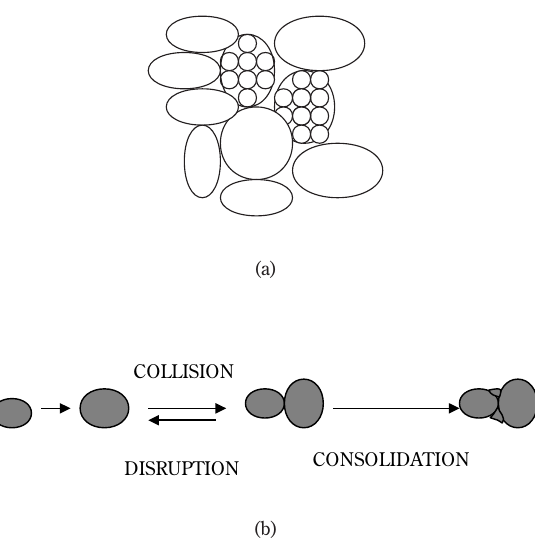
Fig. 1 Shape and creation of a